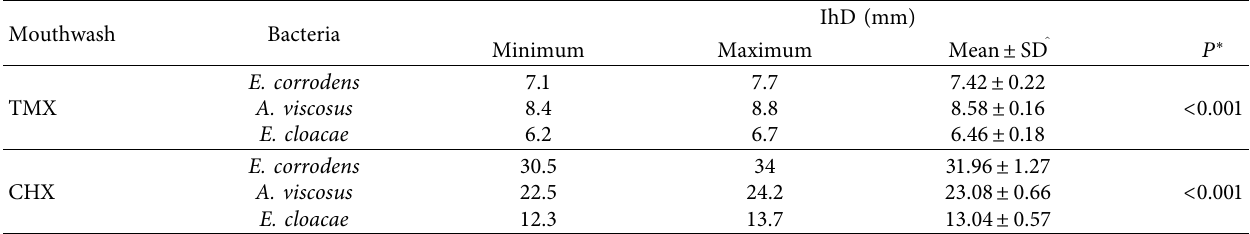
Table 1: Te IhD diference among E. corrodens , A. viscosus , and E. cloacae . Mouthwash Bacteria